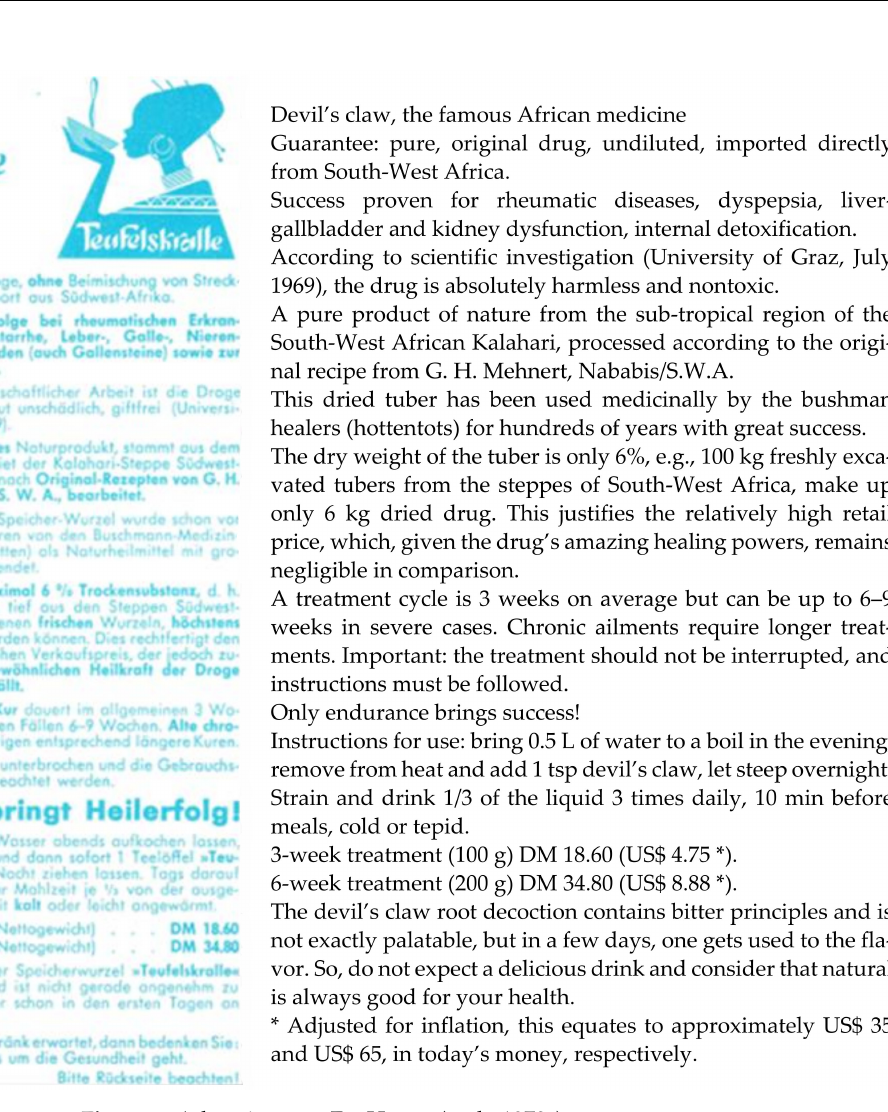
Figure 5. Advertisement Fa. Hagen (early